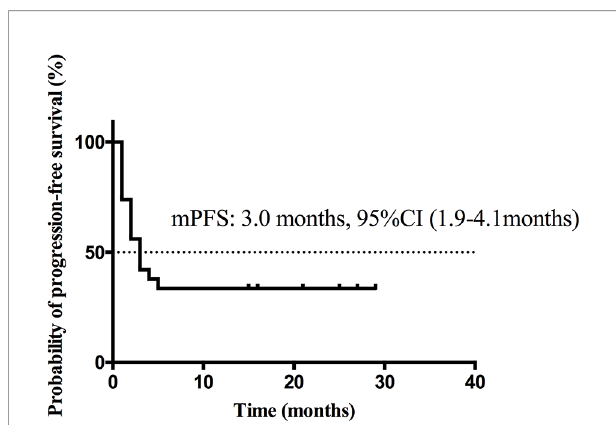
FIGURE 3 | Kaplan-Meier curve of PFS of all patients.